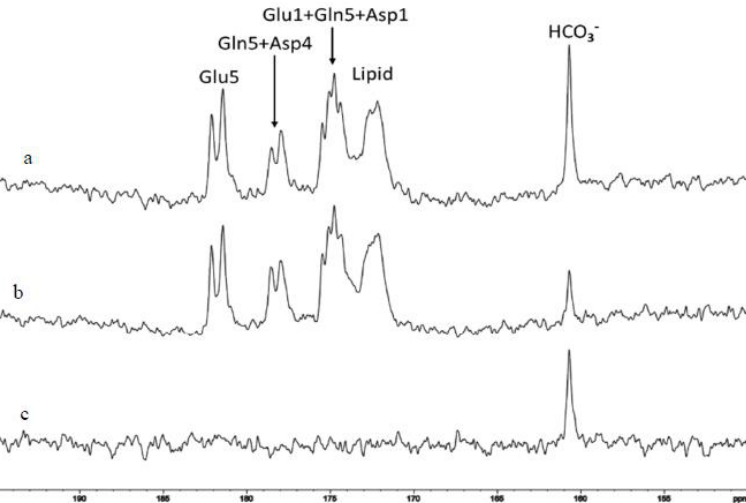
Figure 5. 13 C saturation transfer effect catalyzed by carbonic anhydrase (CA) in the human brain. Spectra were measured from a single subject between 118 and 130 minutes after oral administration of 20% [U- 13 C 6 ] glucose. ( a ) control spectrum with 13 C irradiation at 228 ppm; ( b ) with saturation of carbon dioxide at 125.0 ppm; ( c ) difference spectrum.